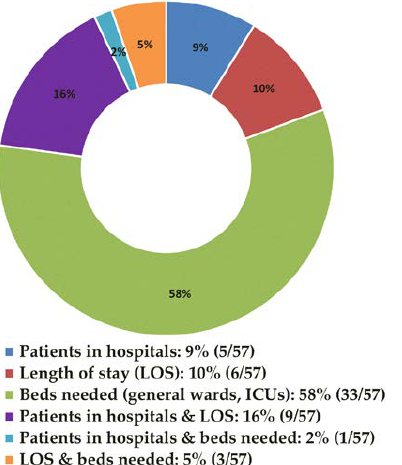
Figure 8. Major areas of focus of modeling studies to predict hospital capacity.